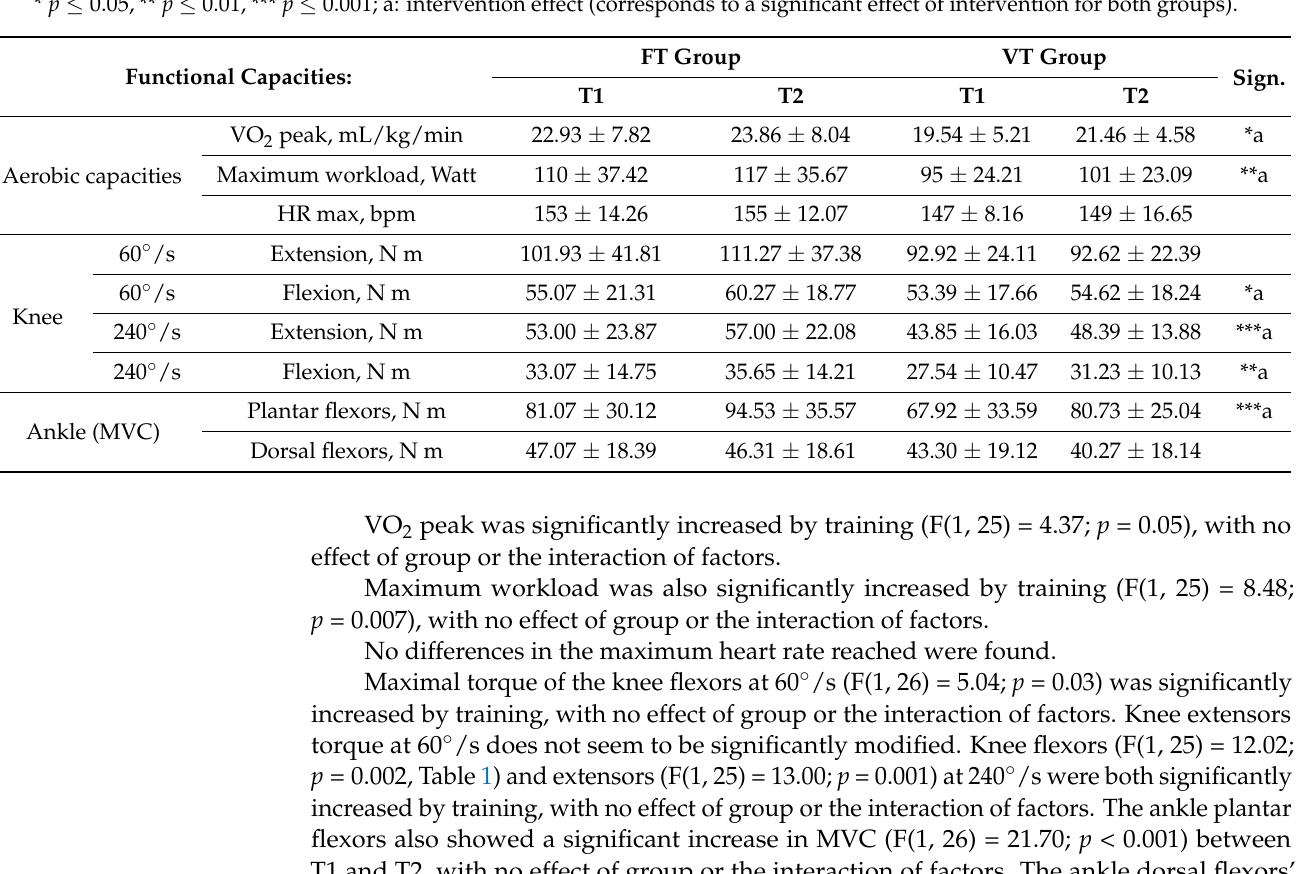
Table 1. Values of the evaluation of aerobic and muscular capacities (Mean ± SD) for Face-to-Face Training Group and Videoconference Training Group before (T1) and after (T2) the training period. VO 2 peak is the rate of oxygen consumption by kg of body. HR max—maximal heart rate reached. MVC—maximal voluntary contraction. Sign.—Significance level. * p ≤ 0.05, ** p ≤ 0.01, *** p ≤ 0.001; a: intervention effect (corresponds to a significant effect of intervention for both